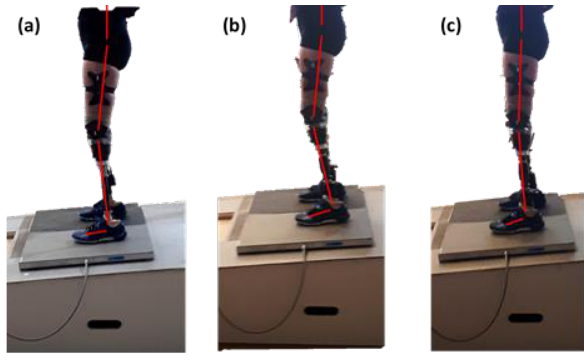
Figure 1: The kinematic strategies of the bilateral trans-tibial amputee participant using (a) FIX, (b) HYD and (c) MPF. Kinetics (bodyweight